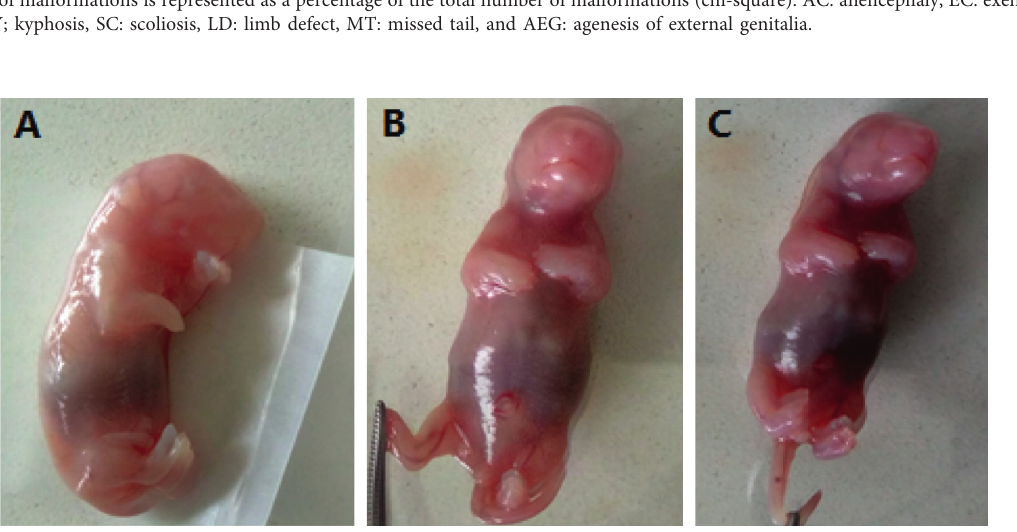
Figure 3: Live rat fetuses from high-dose rat groups: (a) fetus of the pair-fed control group, (b) fetus of the 130mg/kg group, and (c) fetus of the 260 mg/kg dose